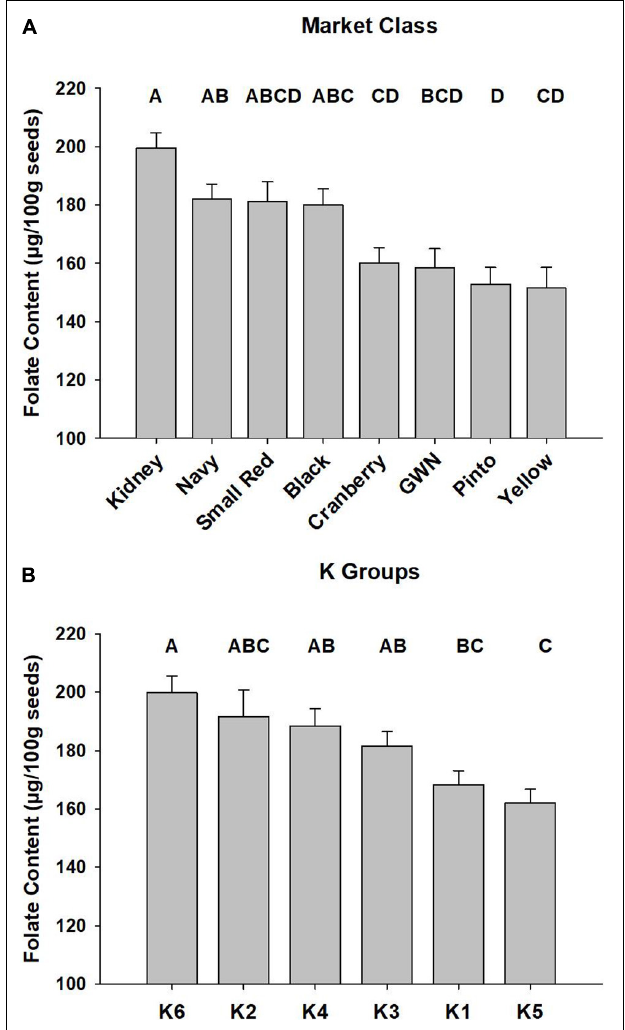
FIGURE 2 | Mean total seed folate of P. vulgaris accessions among market classes and subpopulations. Least squared means of market classes are presented in panel (A) and subpopulations, defined by the K Groups, are presented in panel (B) . Error bars represent SEM of two biological replications of P. vulgaris accessions grown in a RCBD across 2 years. Significant differences are represented by letter codes above bars, and Tukey’s adjustment was applied to the PROC MIXED ANOVA in SAS (Cary,